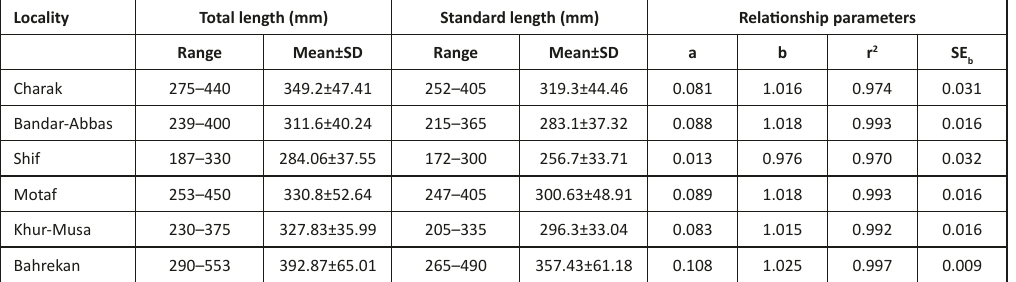
Table 3. Length-length relationships between total length (TL) and standard length (SL) of P. indicus in the Persian Gulf Coastal Waters (number of individuals for all localities were 30). Locality